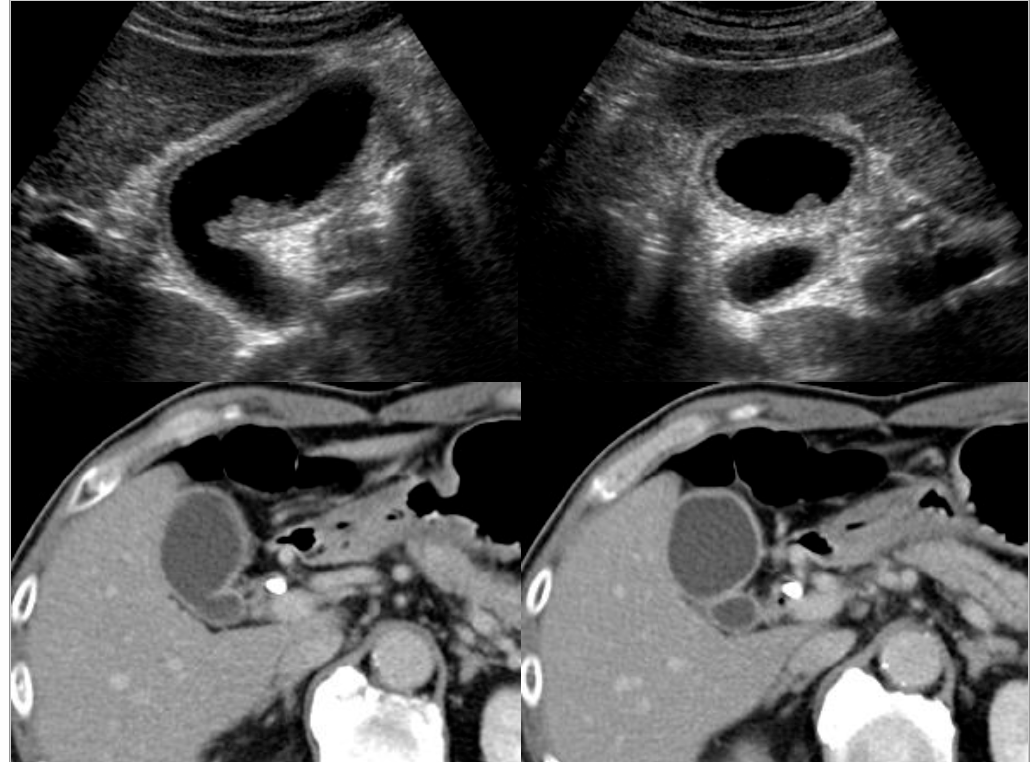
Figure 3. US (3-layer type) and CT (1-layer type) findings of a case with a diffuse type of IgG4-sclerosing cholecystitis.